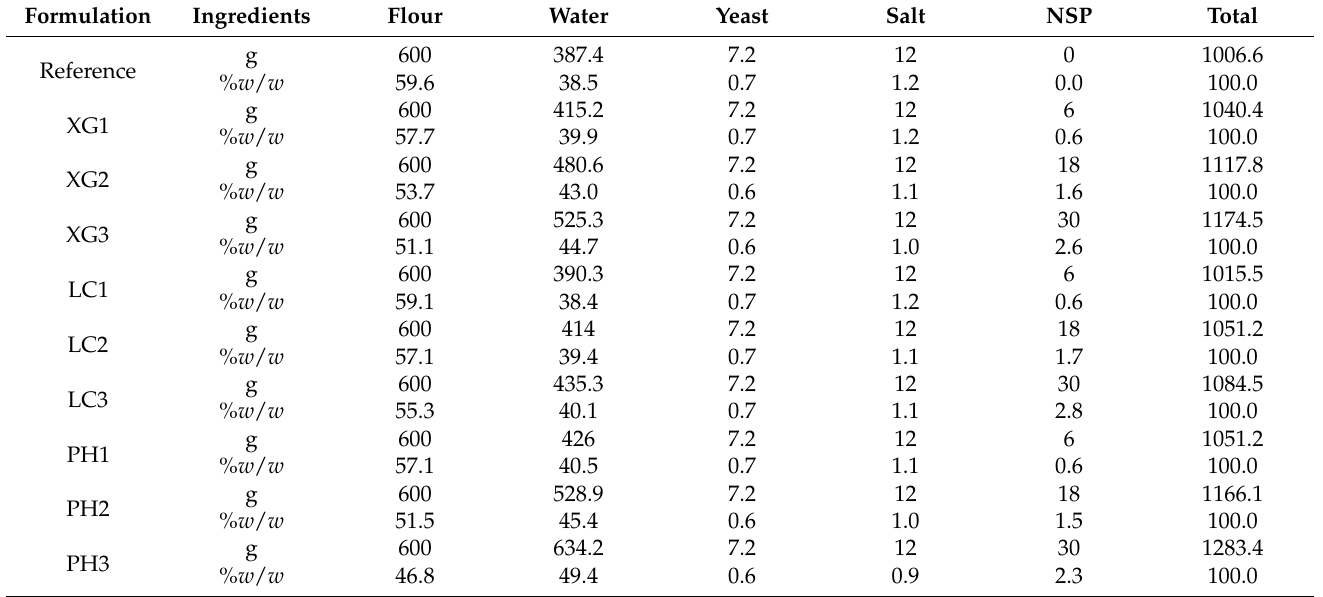
Table 1. Formulation of bread doughs containing different concentrations of xanthan gum (XG1, XG2 and XG3), lambda-carrageenan (LC1, LC2 and LC3) and psyllium husk (PH1, PH2 and PH3), respectively. The reference sample is control without added